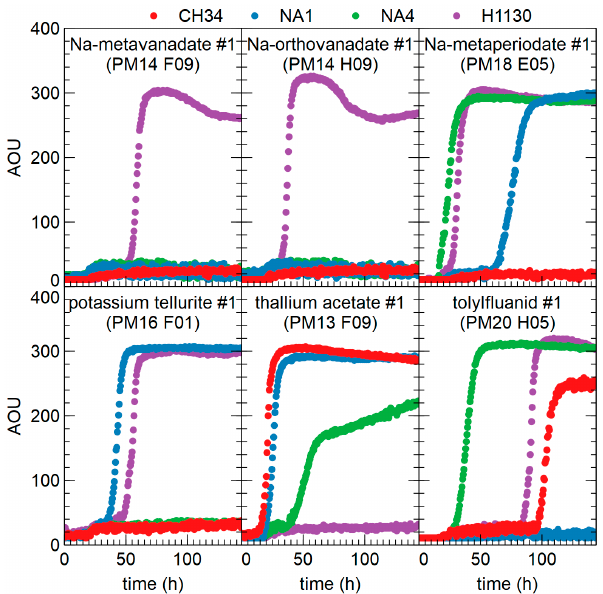
Figure 15. Growth kinetic of C. metallidurans CH34, NA1, NA4 and H1130 in the presence of different chemicals (lowest concentration in the phenotypic microarrays is shown) (AOU = arbitrary OmniLog units).